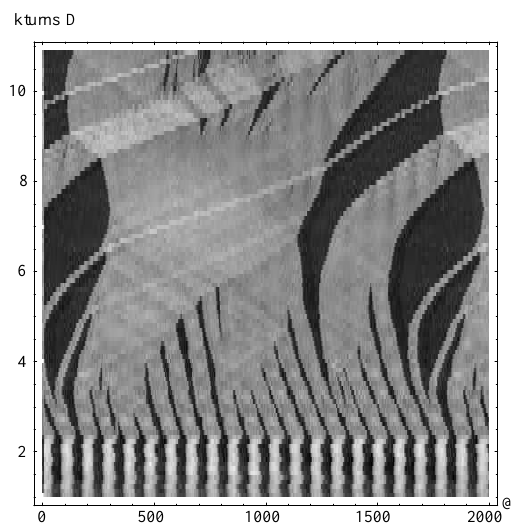
FIG. 13. 3.2 3 10 12 protons, one trace each 100 turns, vertical span 16.7 ms, V rf (cid:1) 0.6